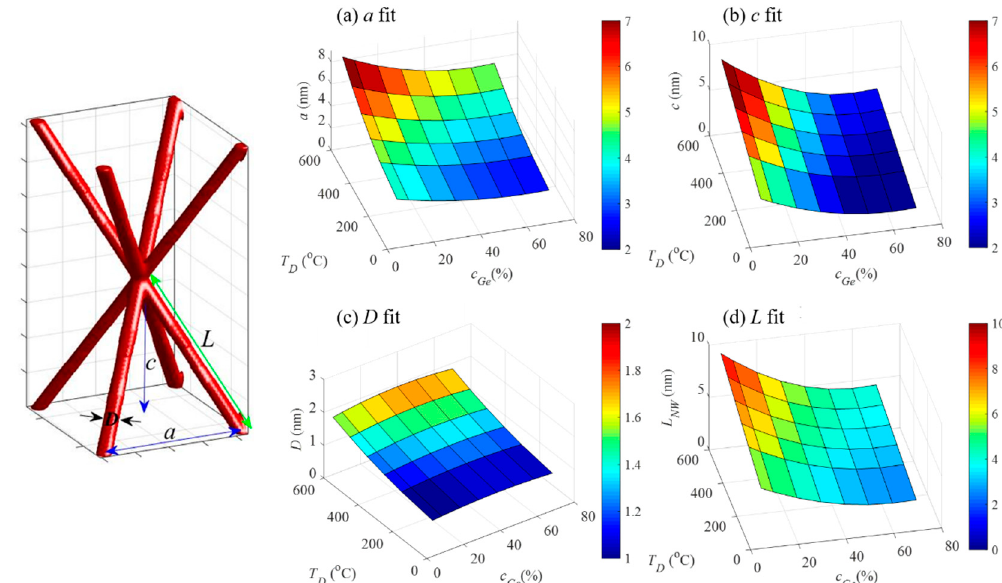
Figure 3. Dependence of the structural parameters of QW networks including ( a ) in-plane separation a , ( b ) vertical separation c , ( c ) QW diameter D , and ( d ) QW length L on the deposition parameters. The parameters are indicated in the simulated unit-cell structure of the prepared 3D networks with a BCT arrangement of the network nodes, shown in the left. Table 2 . Fitting results of the dependence of structural parameters on deposition conditions. The shape of every function was the same: (cid:1832)(cid:4666)(cid:1846) (cid:3005) , (cid:1855) (cid:3008)(cid:3032) , (cid:1868) (cid:2869) ,(cid:1868) (cid:2870) , (cid:1868) (cid:2871) ,(cid:1868) (cid:2872) , (cid:1868) (cid:2873) ,(cid:1868) (cid:2874) (cid:4667) (cid:3404) (cid:4666)(cid:1868) (cid:2869) (cid:1846) (cid:3005)(cid:2870) (cid:3397) (cid:1868) (cid:2870) (cid:1846) (cid:3005) (cid:3397) (cid:1868) (cid:2871) (cid:4667) ∙ (cid:4666)(cid:1868) (cid:2872) (cid:1855) (cid:3008)(cid:3032)(cid:2870) (cid:3397) (cid:1868) (cid:2873) (cid:1855) (cid:3008)(cid:3032) (cid:3397) (cid:1868) (cid:2874) (cid:4667) ; parameters for each function are given in its table row. Data for a , c , and D are taken from the GISAXS map fit.